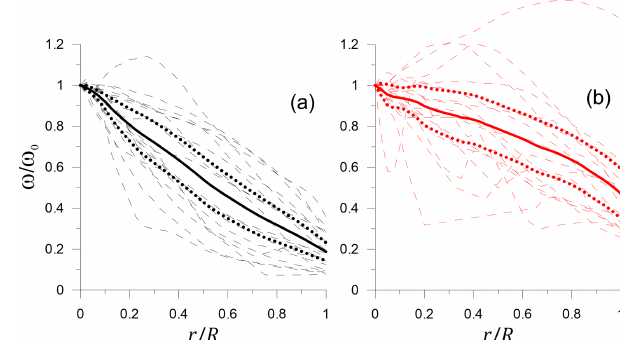
Figure 9. Normalized dependence of the angular velocity of rota- tion ω/ω 0 on the radial distance from the eddy center r/R in the simulated submesoscale eddies: cyclones c1–c18 (a) and anticy- clones a1–a18 (b) (thin dashed curves). The bold solid and bold dotted curves are the ensemble means and the 95% confidence in- tervals, respectively. The black and red curves correspond to the cyclonic and anticyclonic